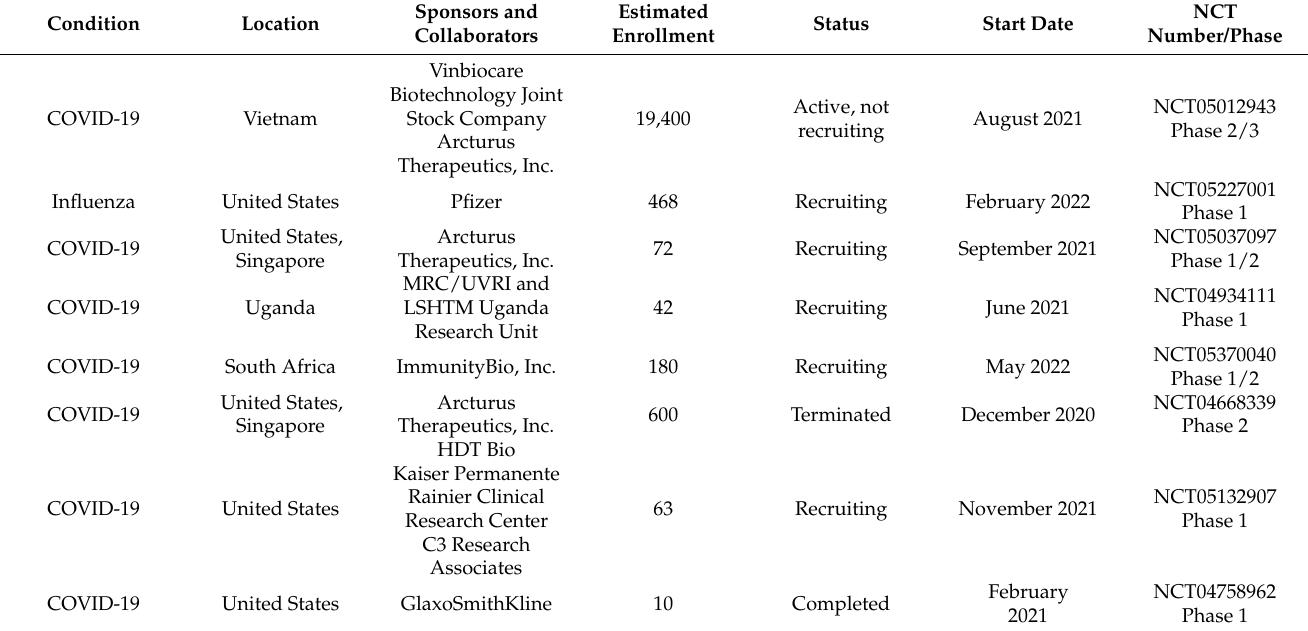
Table 2. List of the interventional clinical trials of self-amplifying RNA as a vaccine (accessed in September 2022). COVID-19, coronavirus disease